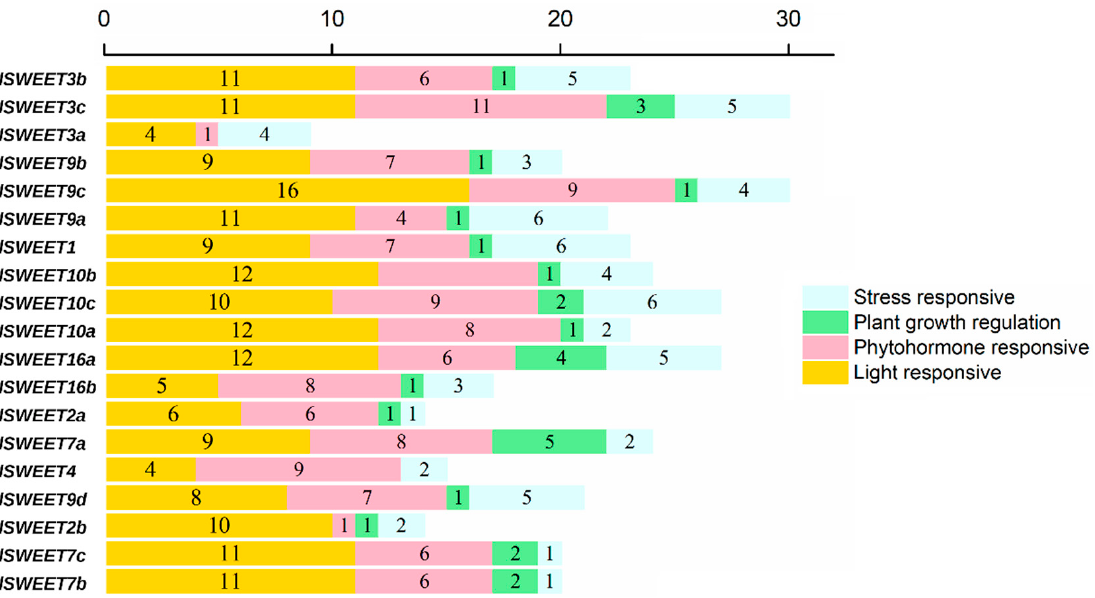
Figure 4. Cis -acting regulatory elements in DlSWEETs promoters.